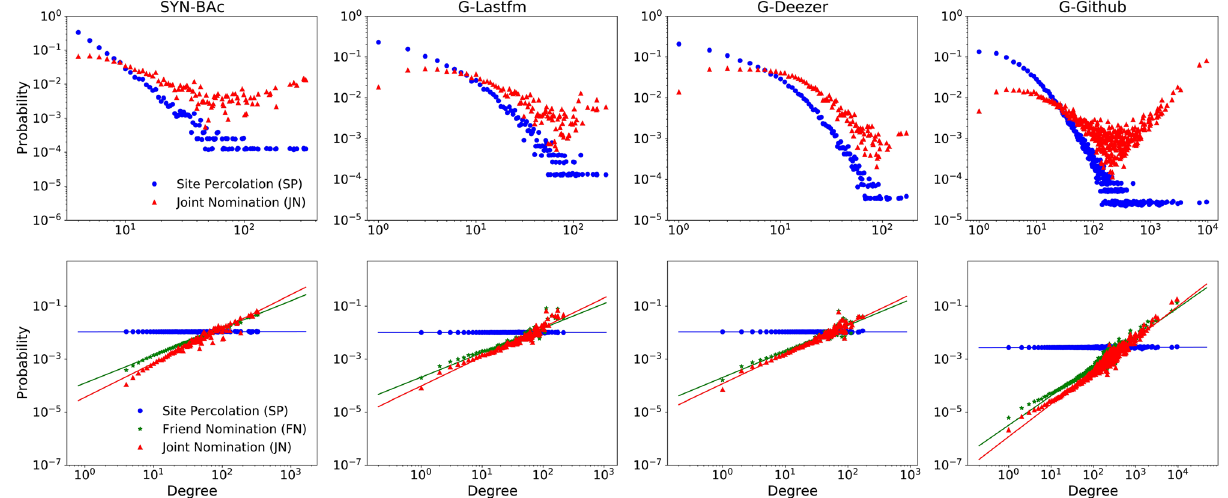
Figure 2. Degree distributions of nodes sampled with the SP and JN strategies (top row), and the degree distributions of the selected nodes normalized by the original network distribution (bottom row). The JN strategy shows a preference for selecting higher-degree nodes, and has a distribution skewed more towards higher-degree nodes than the distributions obtained with the FN